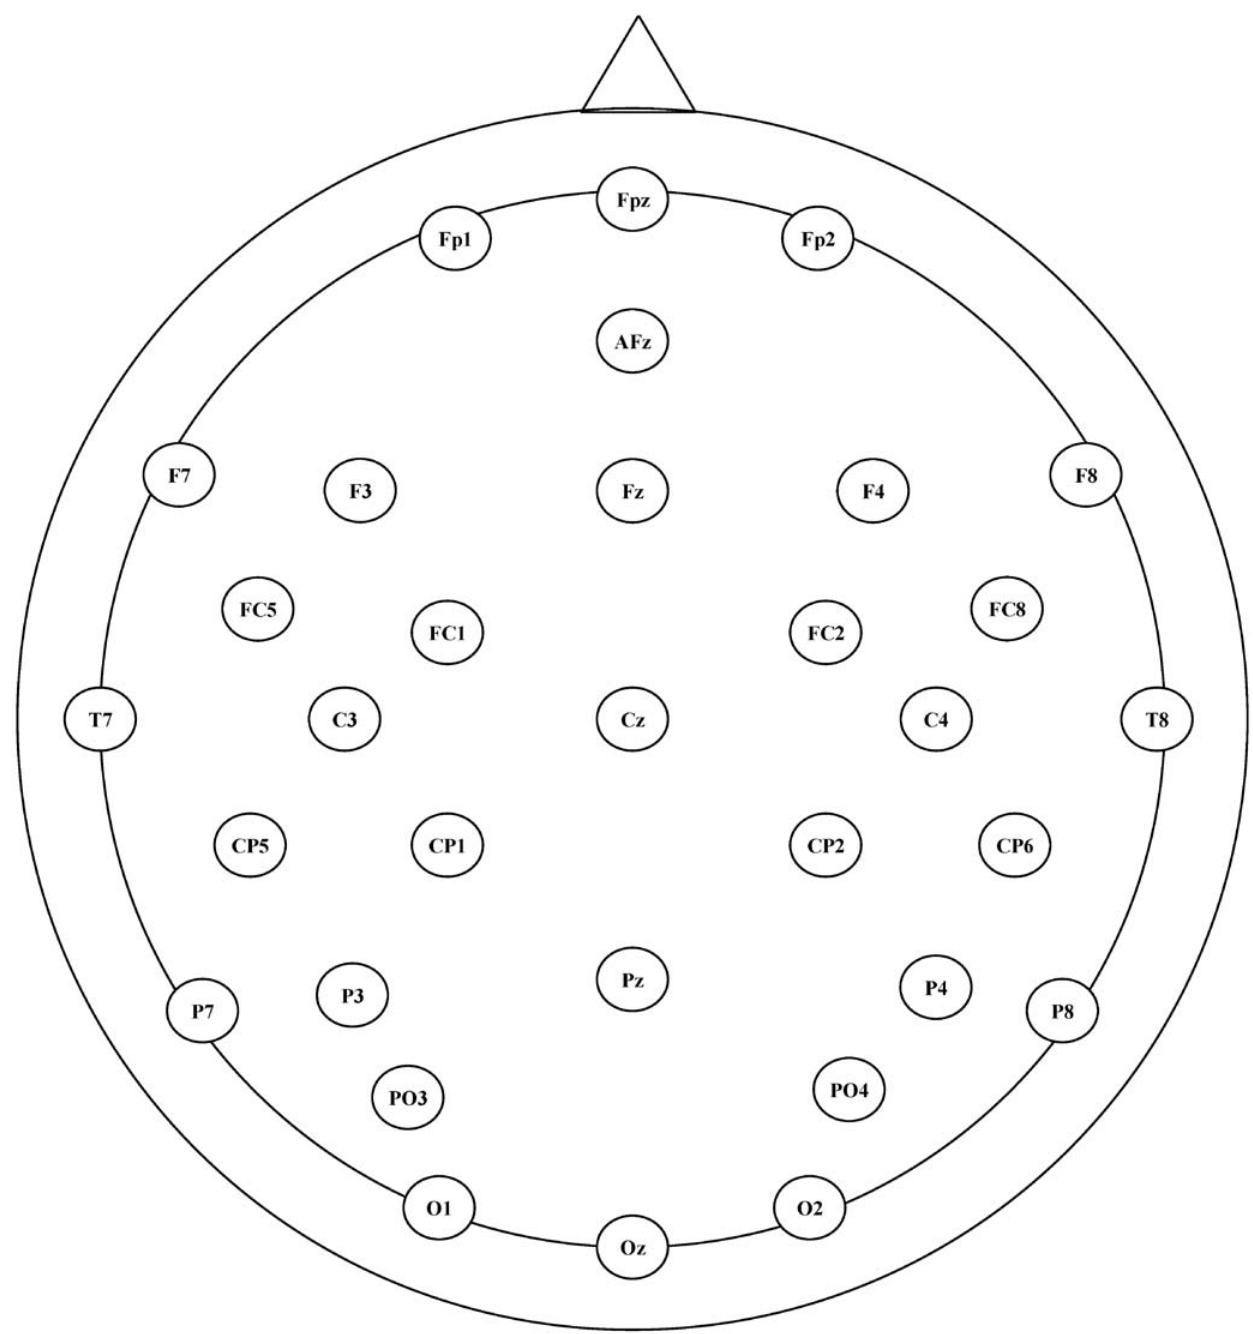
Figure 1. Distribution of electrodes on the scalp.